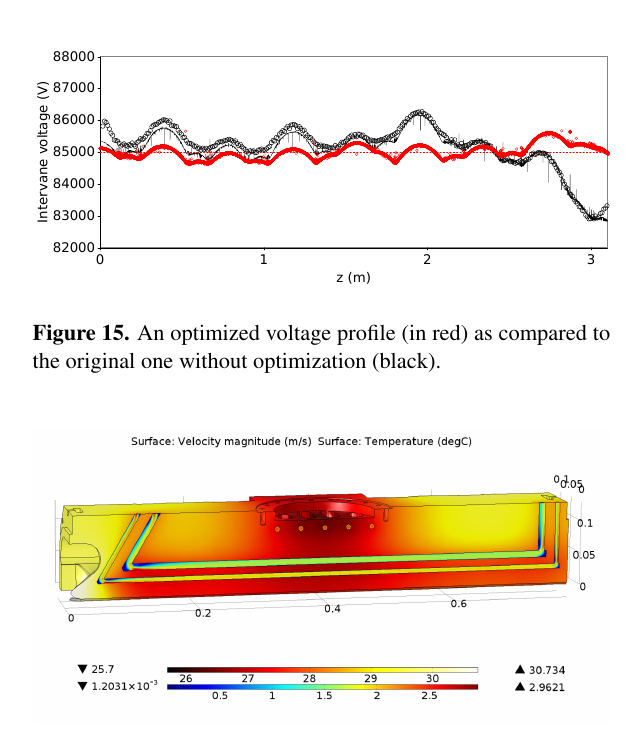
Figure 14. Comparison of the innervate voltage computed using the transmission-line model (full lines) and the voltages extracted from the FEM model of the whole length of the RFQ (open mark- ers). In one situation the vane modulation is not considered and in the other the full details are included. The overlapping of the FEM and the mathematical model curves is very good.